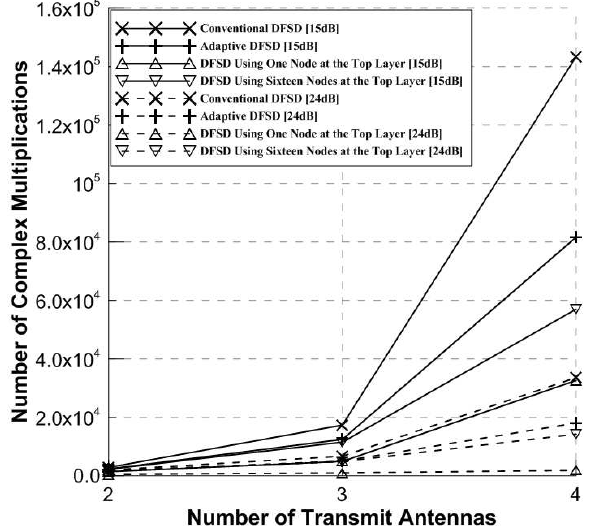
Figure 14. The complexity of the detection schemes according to number of transmit antennas with